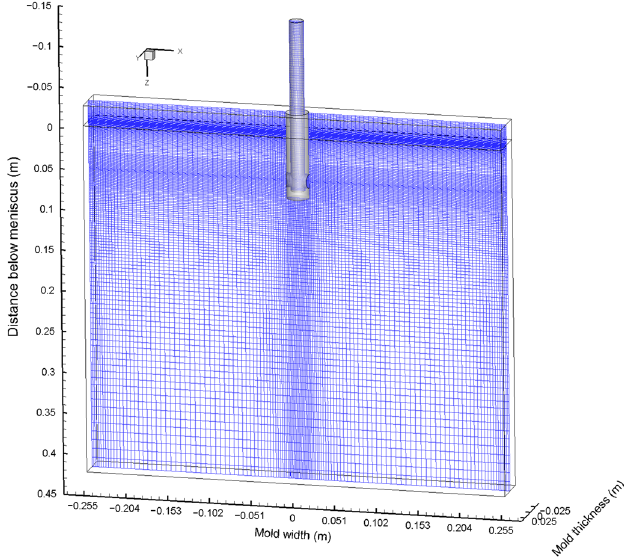
Figure 1. Schematic diagram of the computational domain and mesh system.